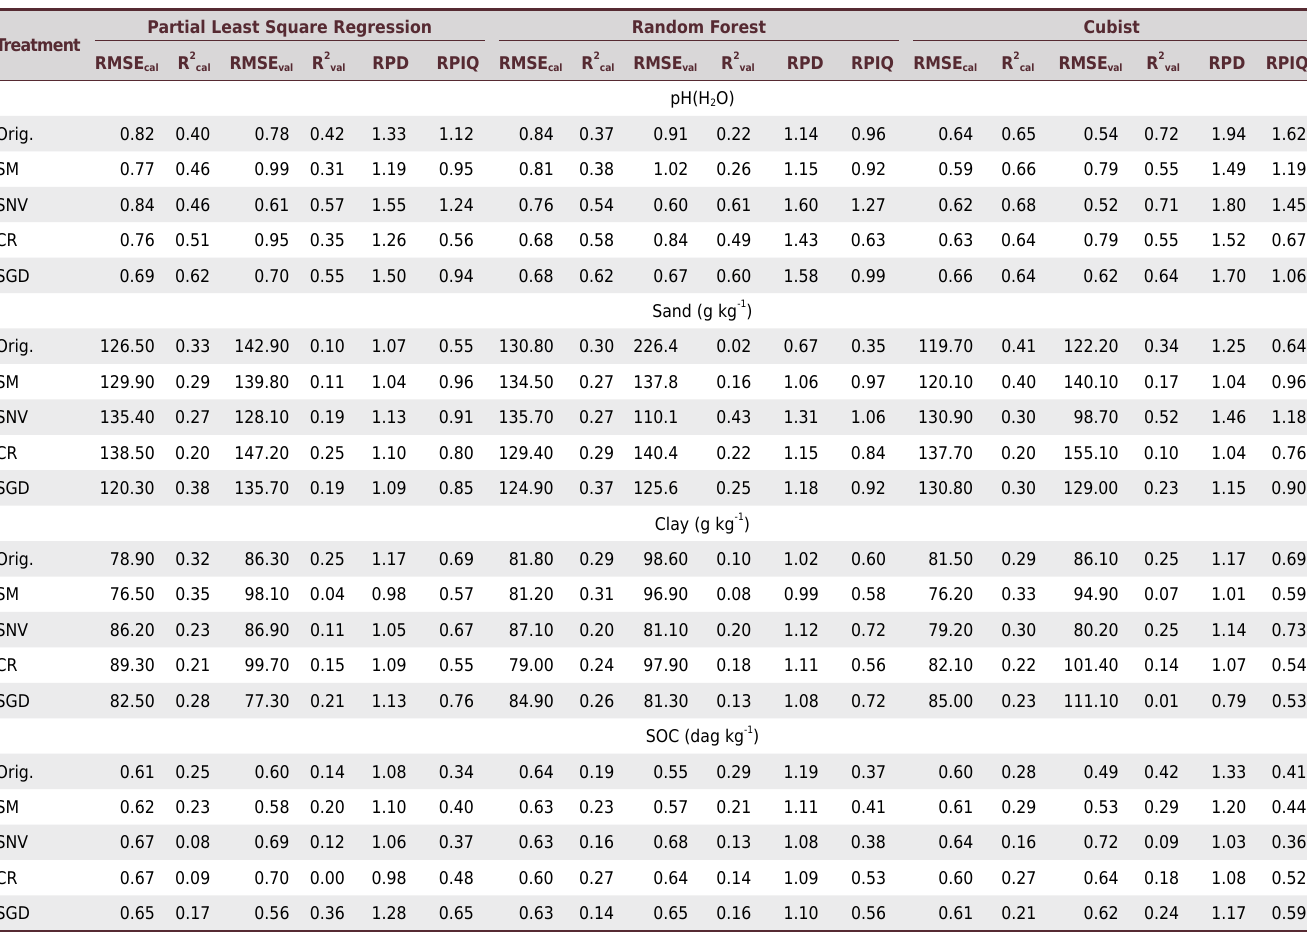
best models for predicting clay content were PLSR using SGD dataset (RMSE = 77.30 g